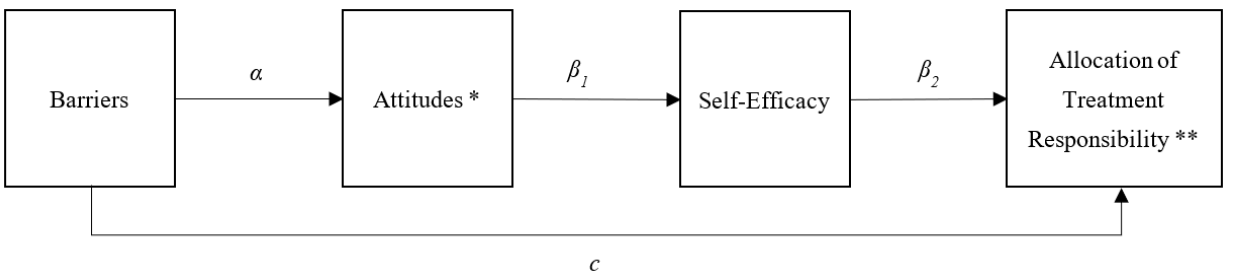
Figure 1. Path model of the relationship between barriers and the allocation of treatment responsibility. Note: the hypothesized model tests the indirect effect of barriers on patient-reported allocation of treatment responsibility through two sequential mediator variables. The indirect effect is calculated as αβ1β2. * Separate path models were estimated for attitudes toward transfer and attitudes toward transition. ** Allocation of treatment responsibility is treated as three separate outcome variables: ATR medications, ATR appointments, and ATR labs. All three outcomes are included simultaneously in the path models.